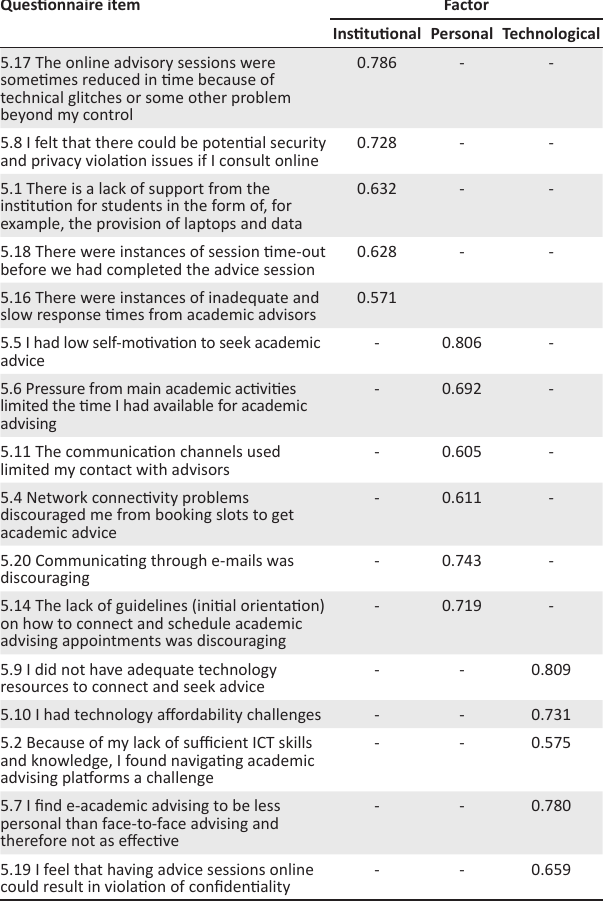
TABLE 5: Factor correlations.